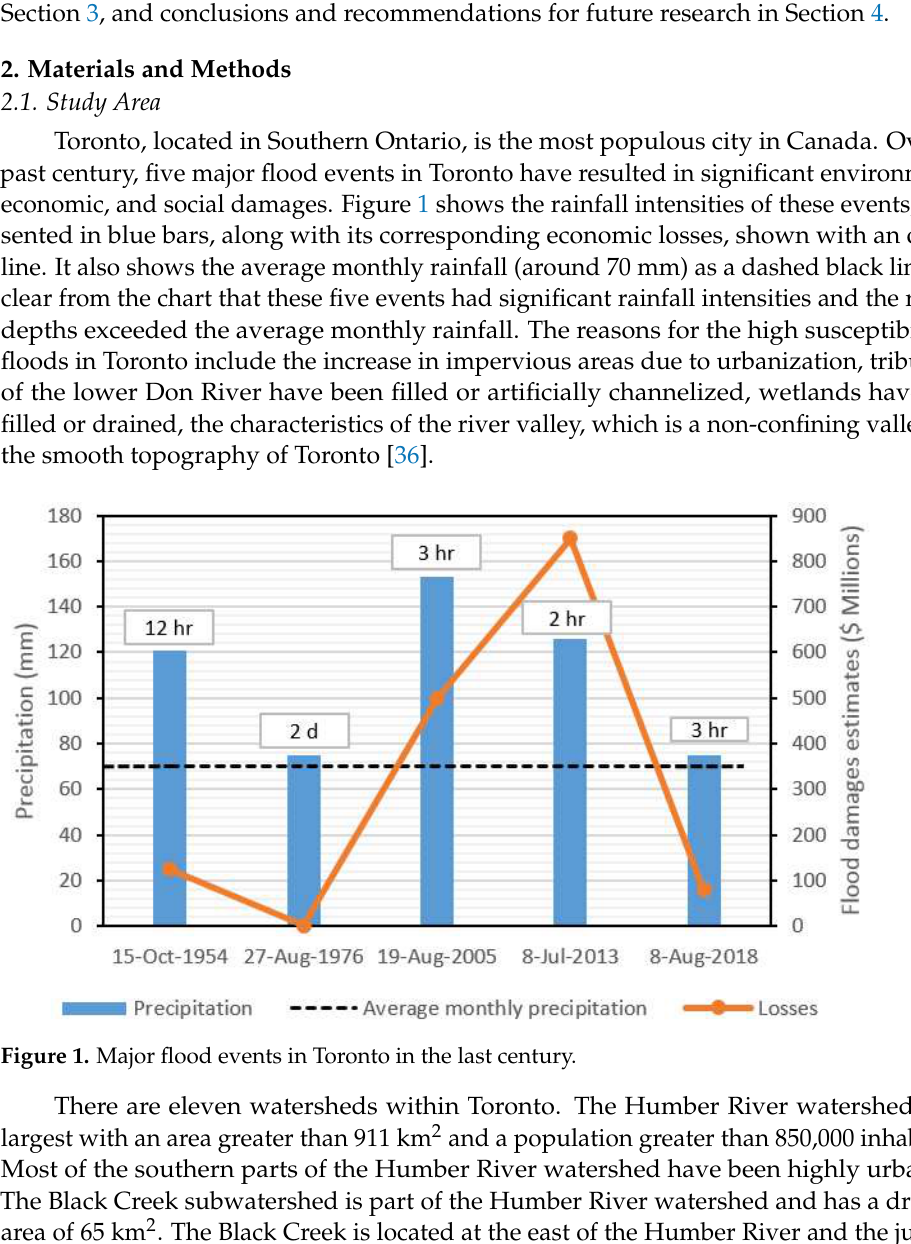
Figure 2. Study area: Rockcliffe region within the Black Creek subwatershed. 2.2. Overview of the Proposed Modeling Methodology In this study, we quantified the flood risk for the Rockcliffe region using the CAPRA method. This stochastic framework considers the frequencies of extreme rainfall events and generates stochastic rainfall scenarios with random shapes, locations, and rainfall intensities based on observed data. The CAPRA platform contains four submodules—(i) IT-NHRain,